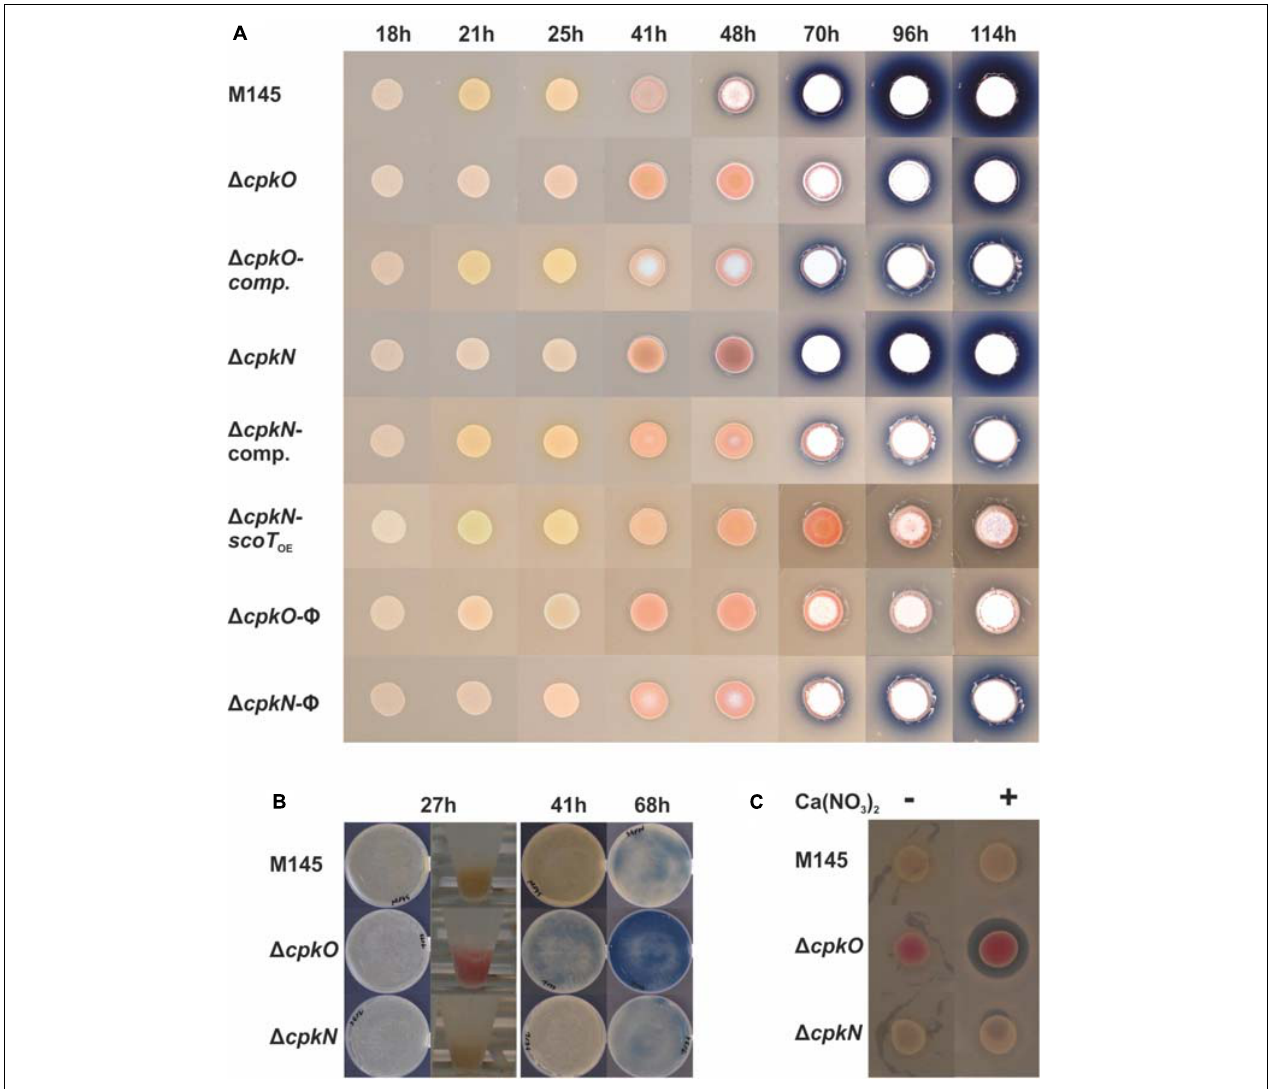
FIGURE 1 | Phenotypes of S. coelicolor A3(2) wild-type (M145) and mutant strains cultivated on solid medium 79NG. CPK, RED, and ACT are visible as yellow, red and blue pigments, respectively. Aerial mycelium is white. (A) Streptomyces strains grown as spots; comp., complemented strains; scoT OE , overexpression of scoT ; ϕ , strains with an empty plasmid. (B) Growth on plates covered with cellophane disks and biomass collected for proteomic analysis (in Eppendorf tubes). (C) Assay for calcium dependent antibiotic production. Inhibition zone around the colony of (cid:49) cpkO strain in the presence of Ca(NO 3 ) 2 indicates CDA